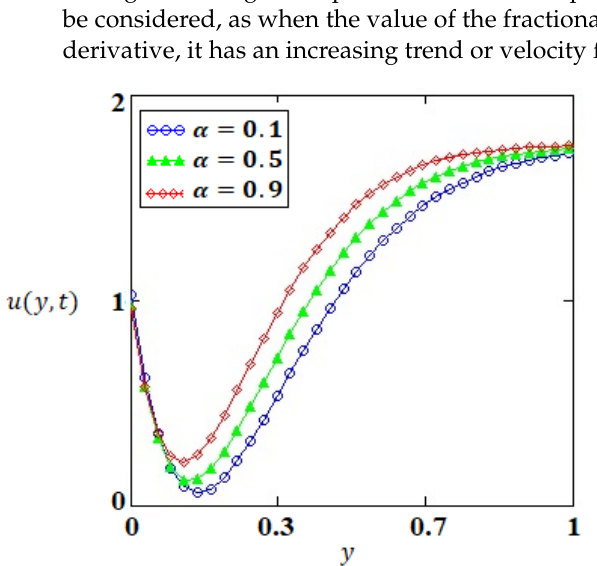
Figure 3. Graphical illustration of fractional approach of Caputo-Fabrizio with ℛ (cid:2868) = 1, 𝐾 (cid:2868) = 0.4, 𝑍𝑇 = 3.7, 𝜔 = 0.5, 𝑀 = 0.5, 𝛼 = 0.6, 𝑡 = 1 for different Prandtl number values. (cid:2868)